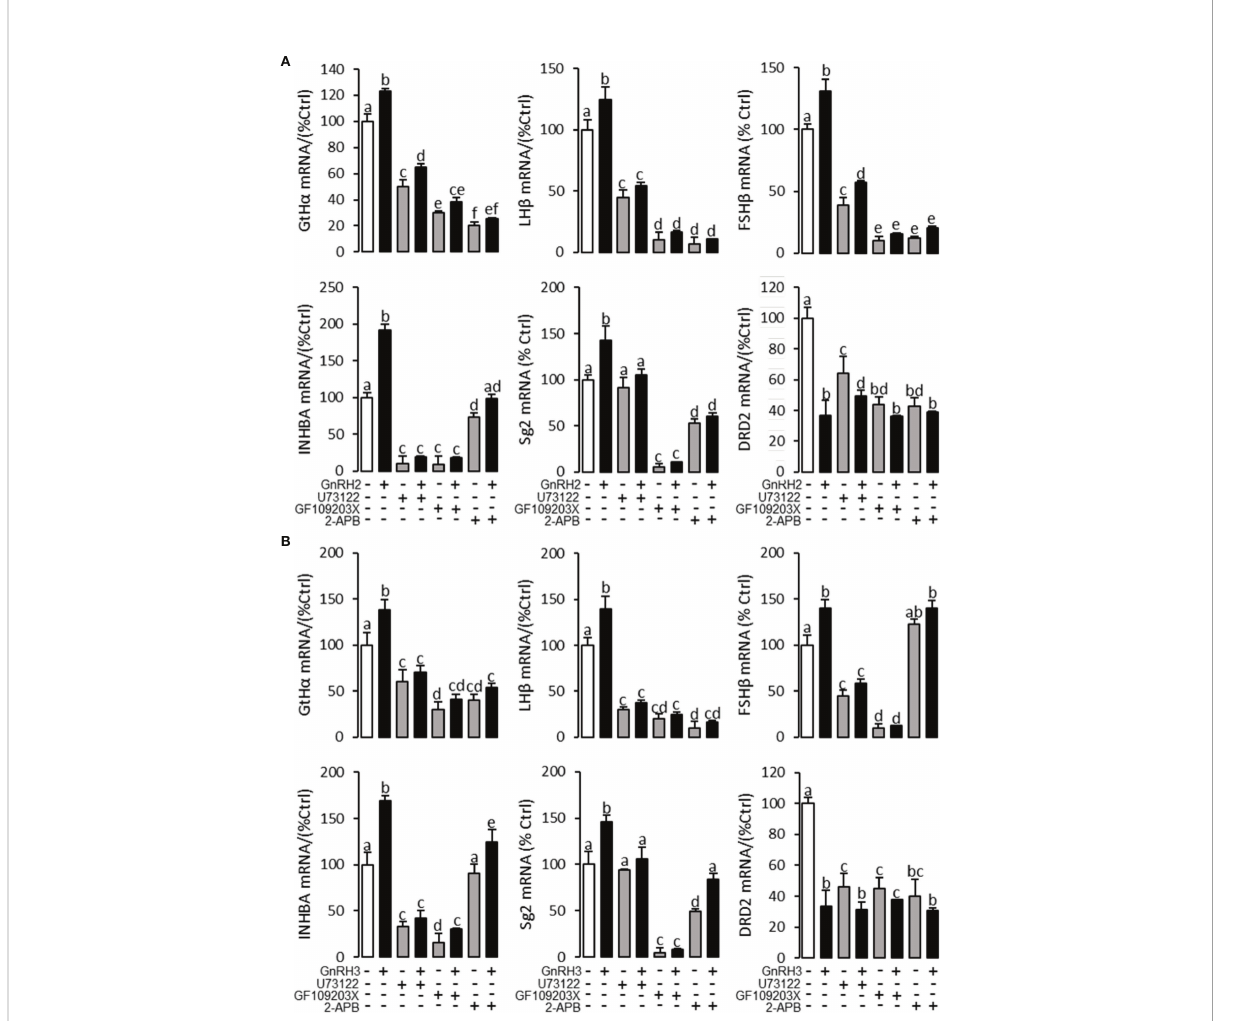
FIGURE 6 Signal transduction for GnRH2- and GnRH3-regulated GtH a , LH b , FSH b , INHBa, SgII, and DRD2 mRNA expression in grass carp pituitary cells. In this experiment, GnRH2 (A) or GnRH3 (B) combined with / without the PLC inhibitor U73122 (10 m M), PKC inhibitor GF109203X (20 m M), or IP3 receptor blocker 2-APB (100 m M) was used to incubate the grass carp pituitary cells for 24 (h) After drug treatment, the total RNA was extracted from the cells for real-time PCR of the respective genes. Data presented are expressed as mean ± SEM, and the different letters represent a signi fi cant difference at p < 0.05 between groups (ANOVA followed by a Dunnett